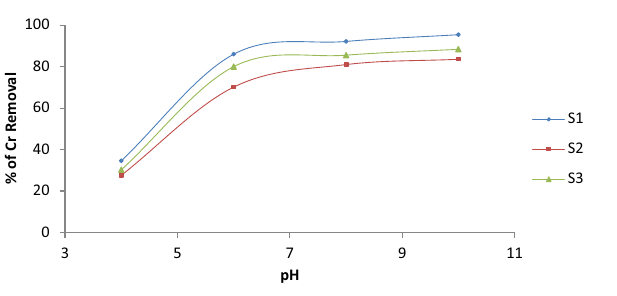
y = 10.641x + 0.0016 R² = 0.9153